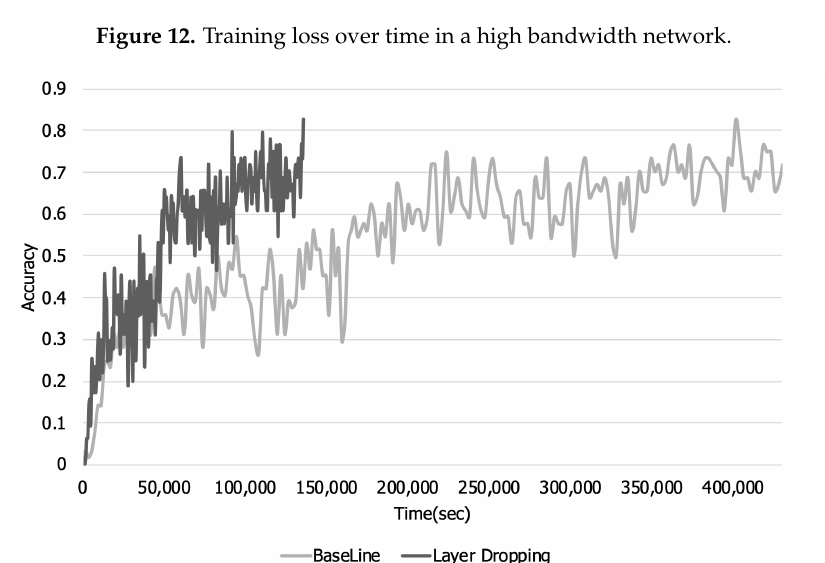
Figure 13. Training accuracy over time in a high bandwidth